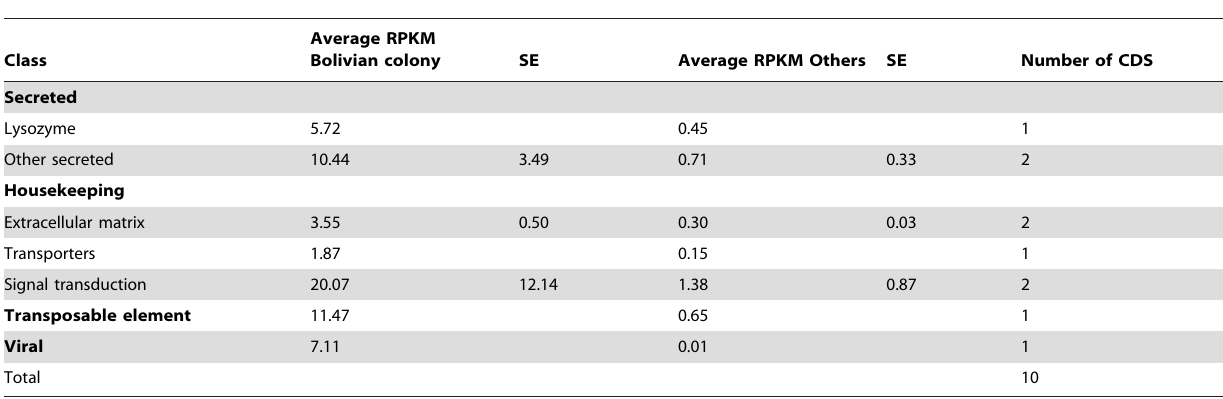
Table 8. Transcripts found overexpressed ( . 10 fold) on Bolivian colony population.